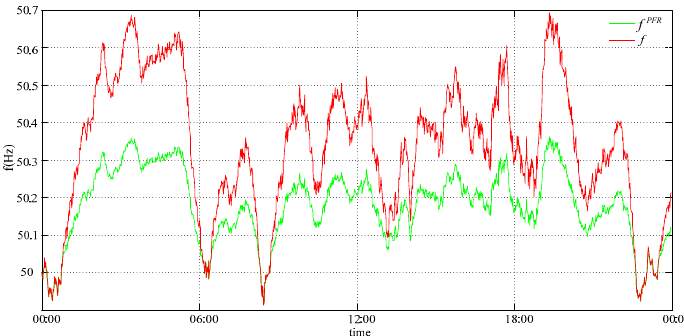
Figure 15. The frequency of the islanded system with and without PFR control.